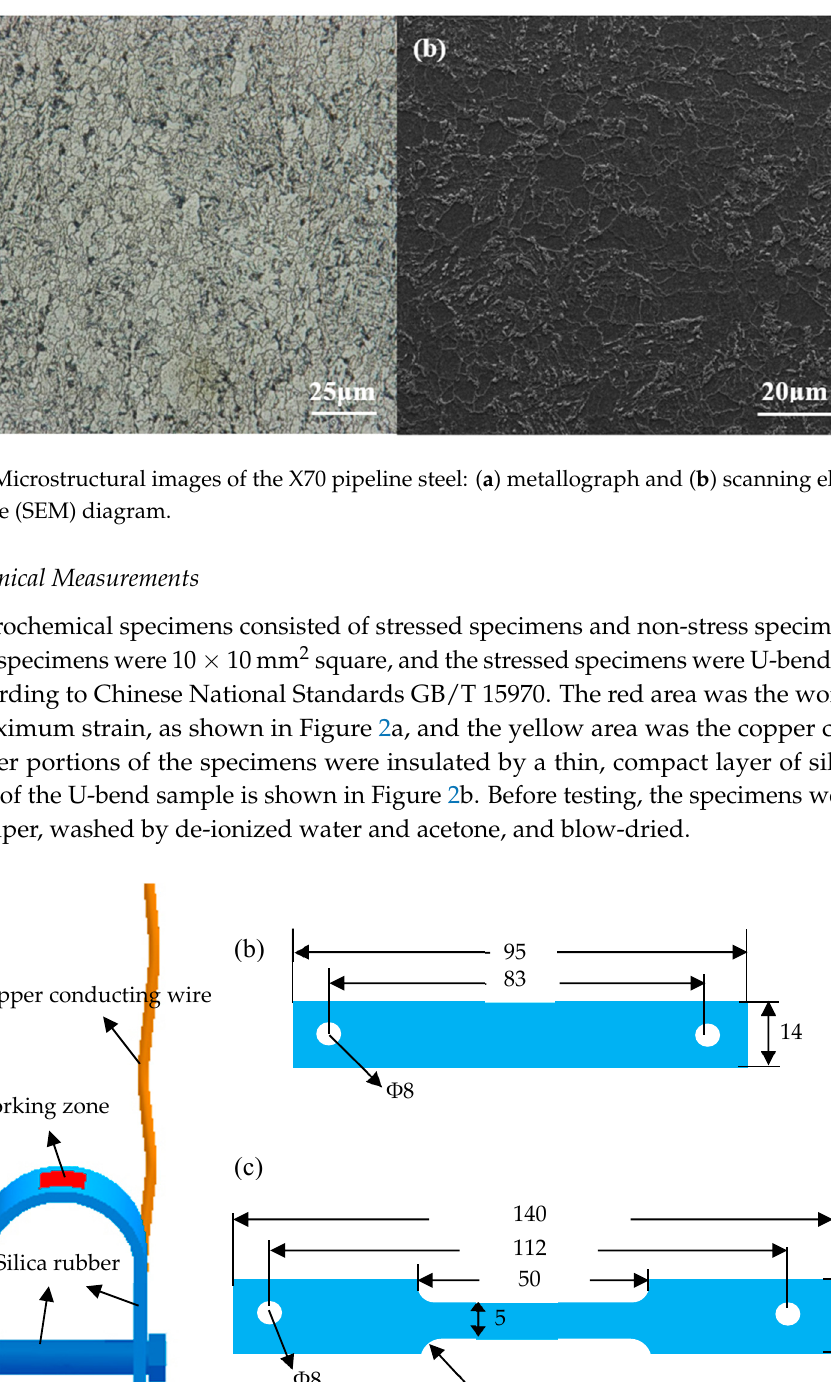
Figure 1. Microstructural images of the X70 pipeline steel: ( a ) metallograph and ( b ) scanning electron microscope (SEM) diagram.